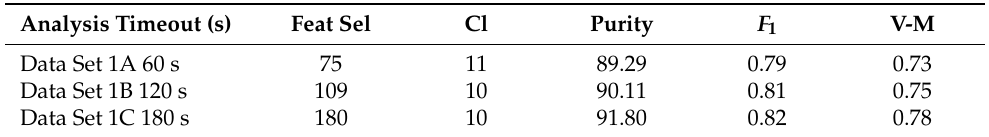
Table 6. VM timeout versus maximum cluster